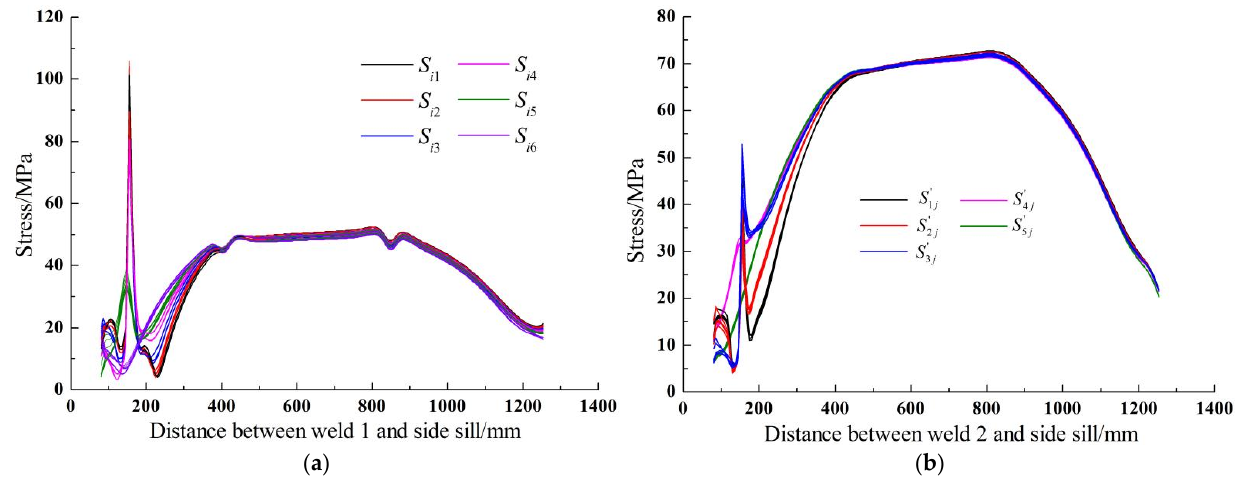
Figure 8. The stress distribution clusters of cross bearer welds. ( a ) weld 1, ( b ) weld 2.